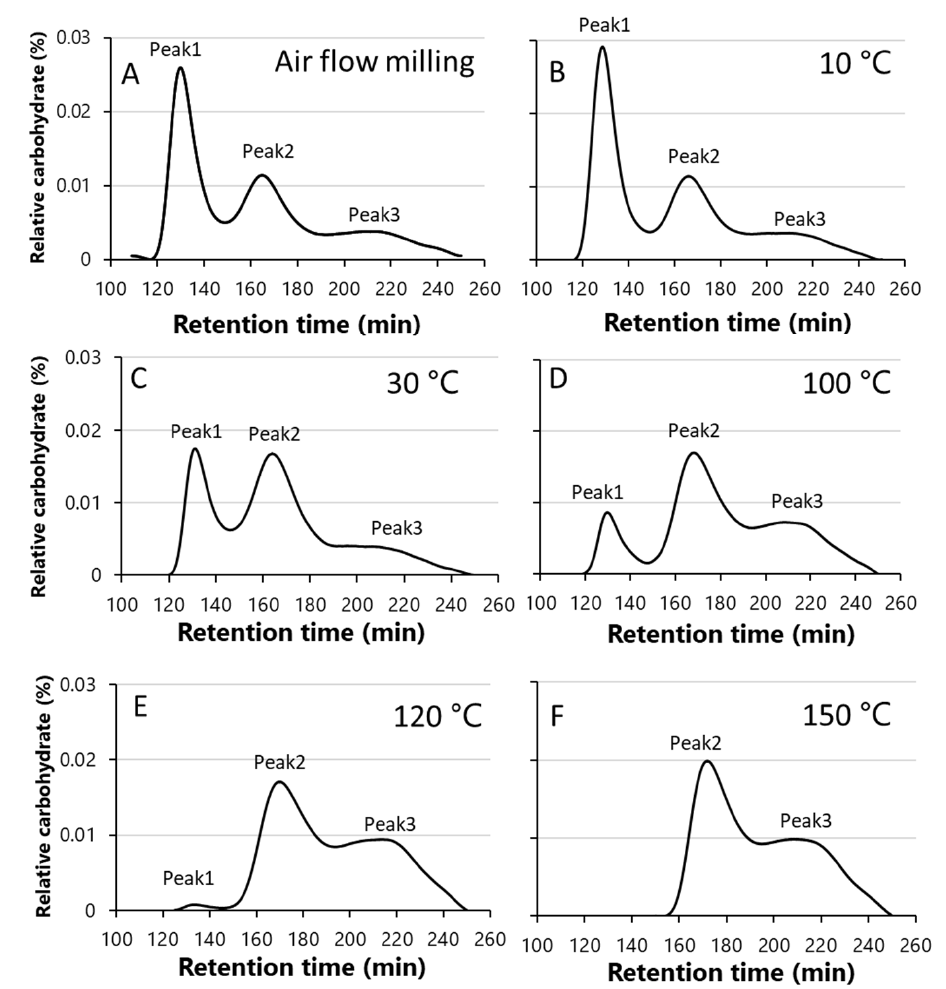
Figure 3. Typical GPC patterns (Toyopearl HW75S × 2-HW65S-HW55S) of rice starch prepared by the SHMM treatment at different temperatures or by air flow milling. ( A ) Rice flour prepared by air flow milling. ( B – F ) Rice flour samples subjected to SHMM at 10 ◦ C ( B ), 30 ◦ C ( C ), 100 ◦ C ( D ), 120 ◦ C ( E ), and 150 ◦ C ( F ). Peaks 1, 2, and 3 represent high-molecular-weight amylopectin, low- molecular-weight amylopectin, and amylose and lower molecular-weight amylopectin, respec-